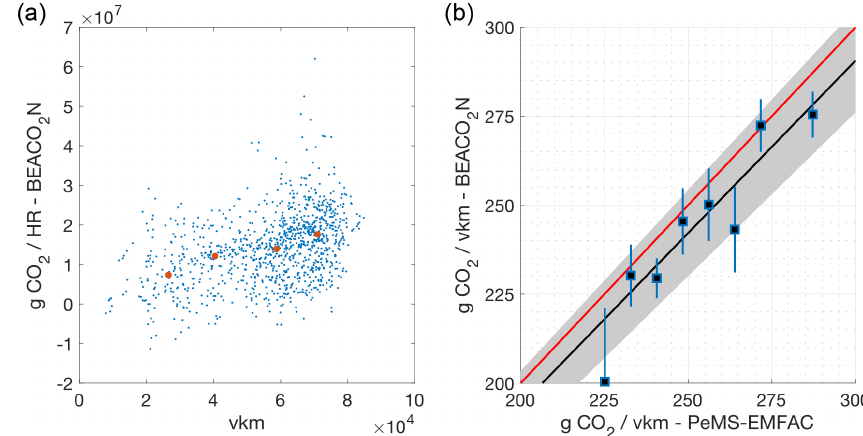
Figure 3. (a) BEACO 2 N-derived emissions vs. vehicle kilometers (vkm) for times corresponding to modeled emission rates of 271.4– 279gCO 2 per vehicle kilometer. Red points represent binned medians used in fitting. (b) BEACO 2 N-derived vs. PeMS-EMFAC-derived emission rates with the uncertainty estimate. The black line shows the fit weighted by variance: y = 0 . 97( . 01) x . The gray envelope is the 5% deviation from fit, and the red line represents the 1 : 1 line.